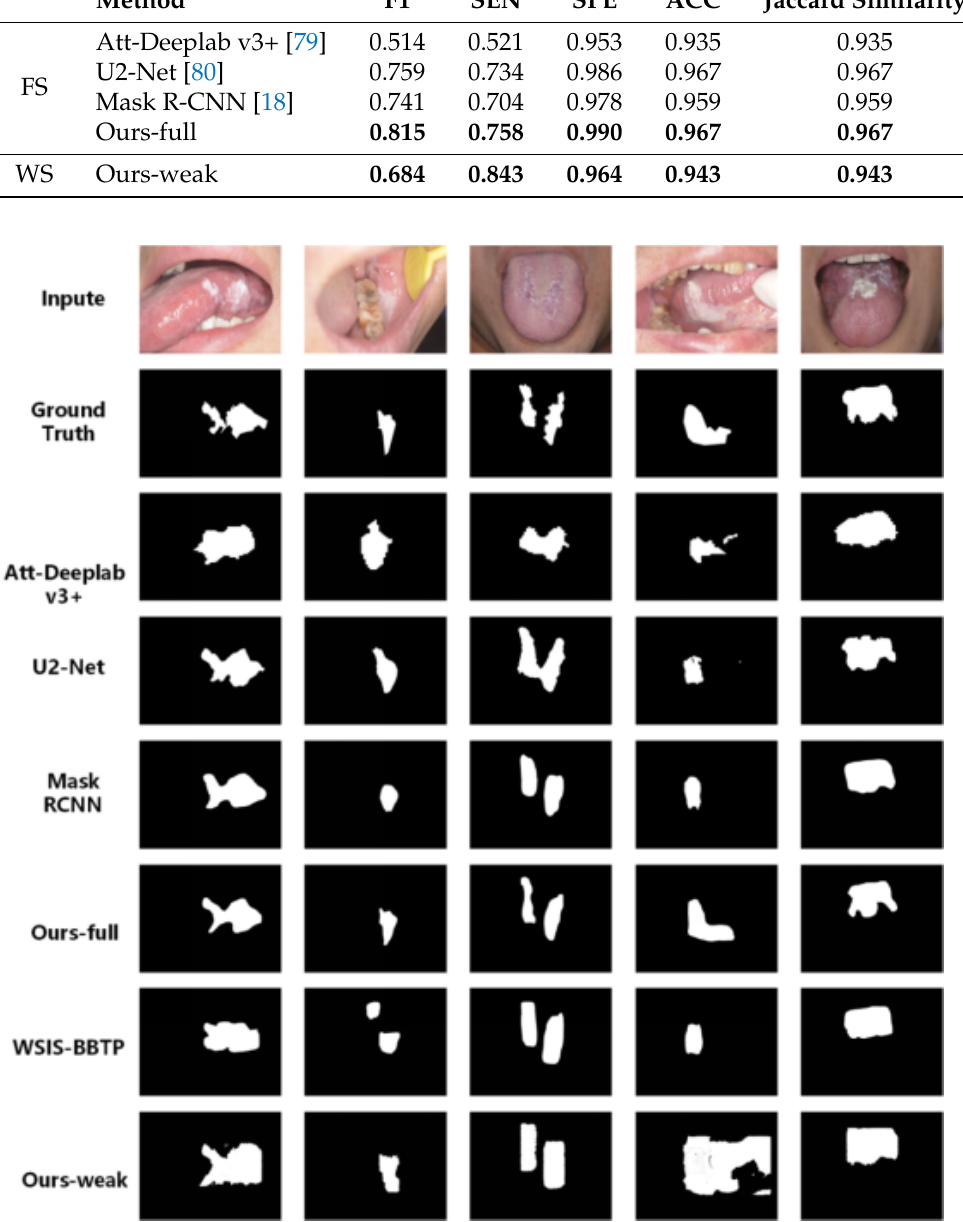
Figure 5. Segmentation results of fully supervised and weakly supervised segmentation method on the Oral leukoplakia